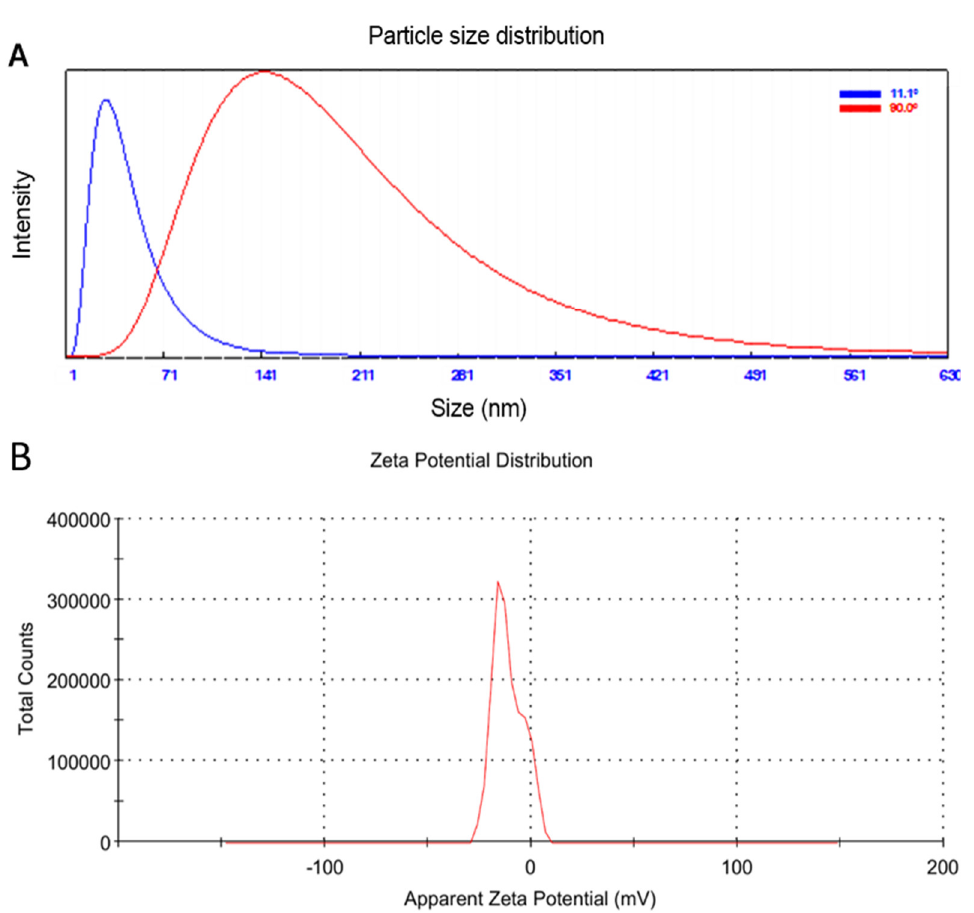
Figure 2. Particle size distribution using dynamic light scattering technique ( A ), and zeta-potential distribution analysis ( B ) of biosynthesized Ag-NPs.